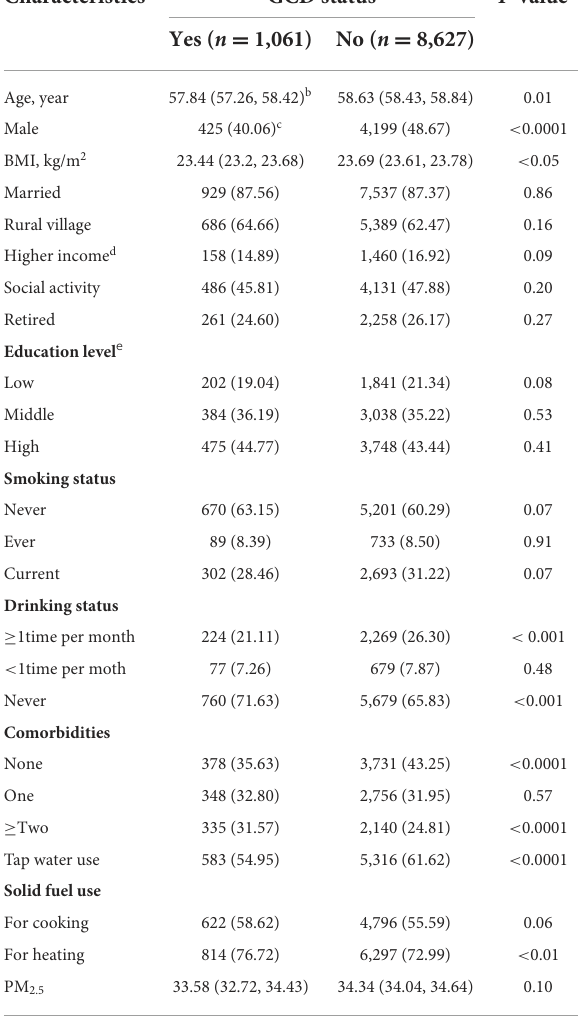
TABLE 1 Characteristics of the included participants according to GCD incidence in follow-ups. Characteristics